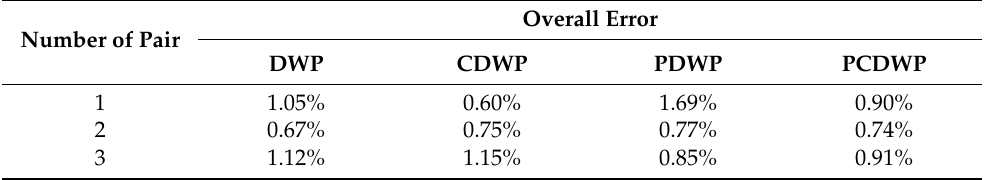
Table 2. Overall error Nusselt number for the installation of DWP, CDWP, PDWP, and PCDWP